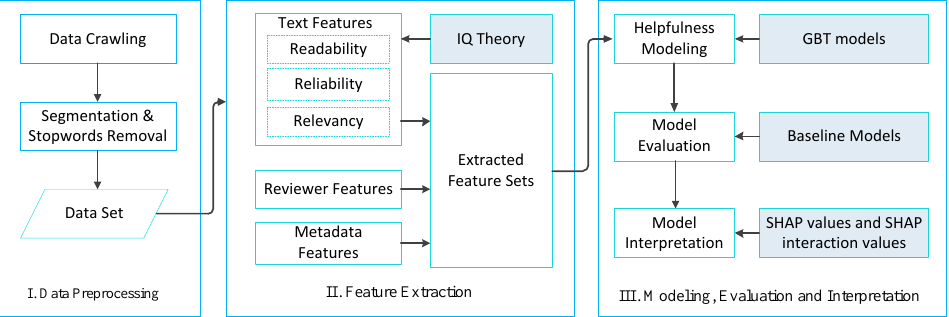
Figure 1. Basic procedure for review helpfulness interpretation.